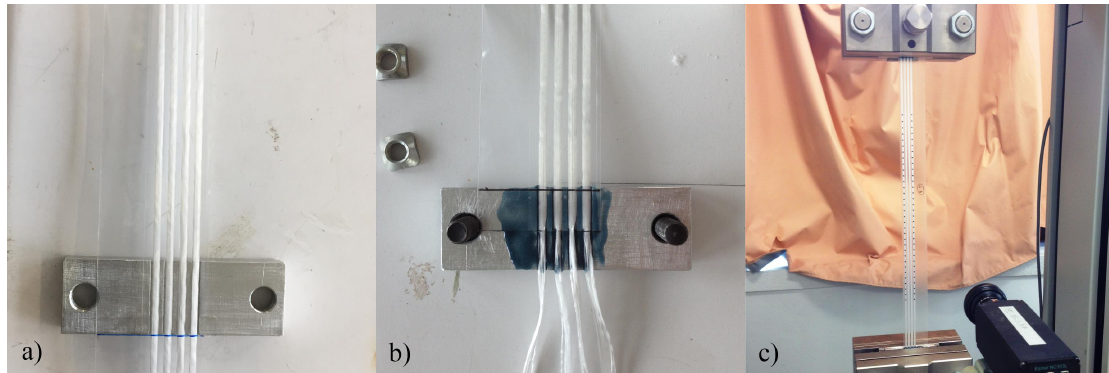
Figure 12. ( a ) Assembly of clamping parts and straps before bonding according to method 1. ( b ) Assembly of clamping part and straps according to method 2: the film is bonded over half the width of the clamping parts and the strands and the fibre are bonded over the other half. ( c ) Assembly of a test specimen in the tensile